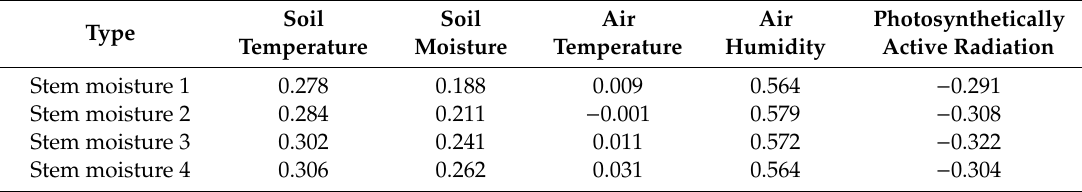
Table 9. Correlations between poplar stem water content and micro-environment parameter set.